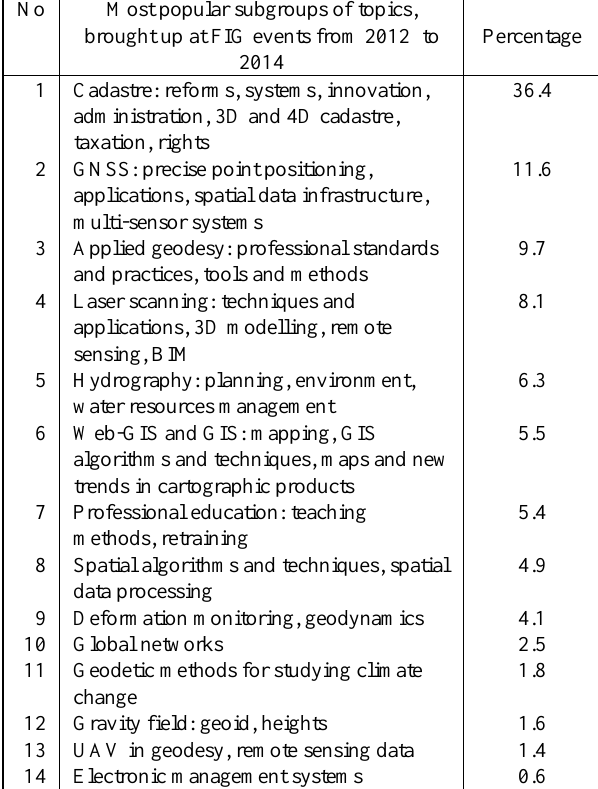
Table 1. Frequency of publications devoted to particular topics in the FIG materials 2012-2014